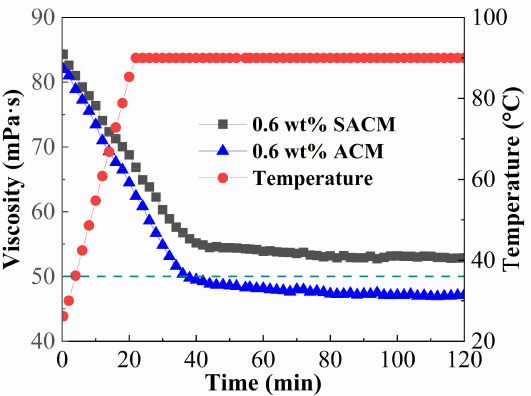
Figure 10. Temperature and shear resistance performance of suspension diluent and powder solution.